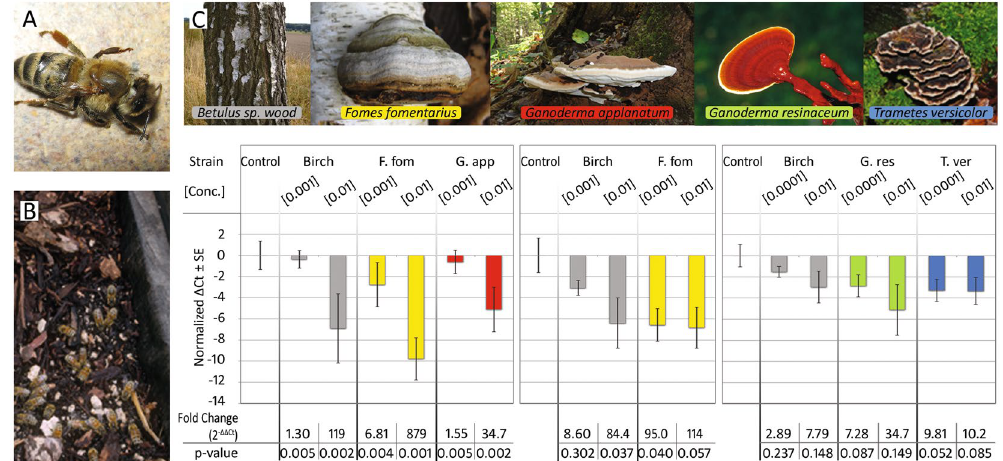
Figure 1. Extracts from fungi reduced deformed wing virus (DWV) in honey bees. ( A ) DWV shortens the lifespan of workers and causes developmental abnormalities in honey bees including deformed wings. ( B ) Honey bees forage on fungal mycelium where they ingest liquid exudates. ( C ) Bees fed extracts from polypore mycelium exhibited lower DWV virus titers. In three different trials, mixing fungal extracts into caged bees’ sucrose syrup food significantly reduced the levels of DWV as assayed by qPCR. Notably, the extracts of F. fomentarius mycelium reduced DWV more than 800-fold in the first trial (2-tailed t-test, n = 10, t = 1.12, p = 0.005). For each trial, qPCR Δ Ct values are normalized to mean value of the respective control groups. Photos: